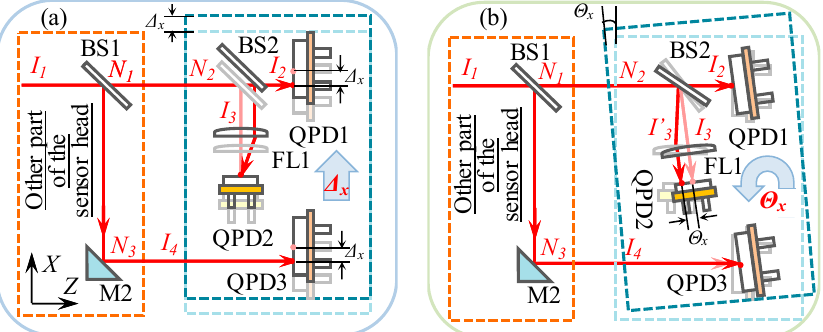
Figure 11. Optical path of the laser beam when the detecting part was applied to: ( a ) A linear displacement of ∆ x , ( b ) an angular displacement of Θ x .